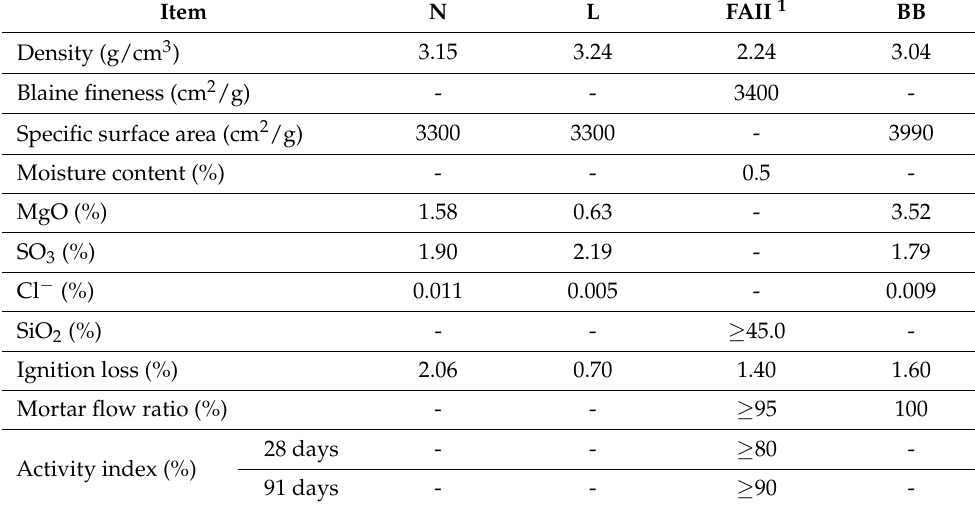
Table 3. Main qualities of cement and mineral admixtures.